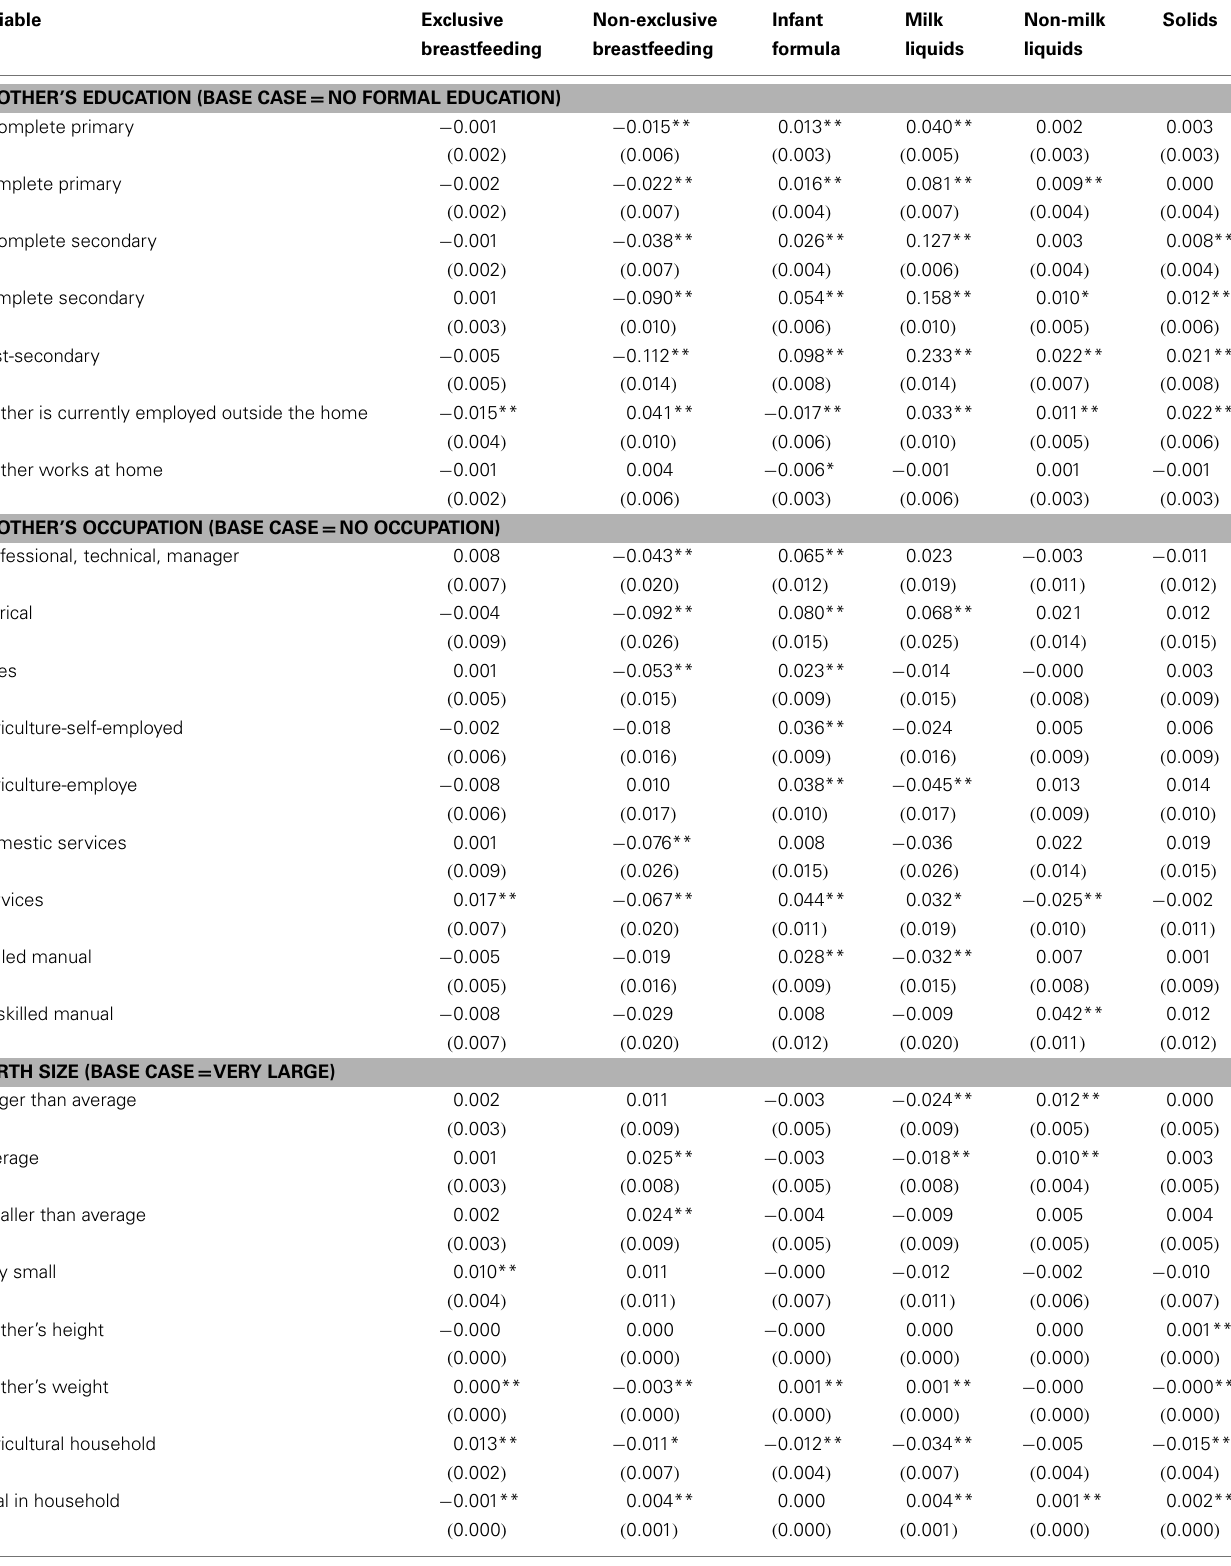
Table 4 |Associations with feeding type, age 1–2years